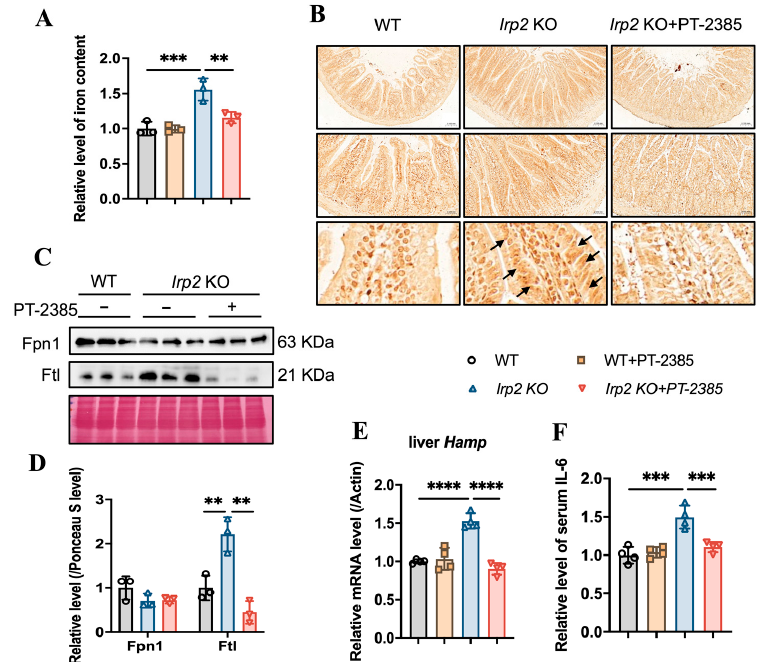
Figure 4. Abnormal iron accumulation is suppressed in the small intestine and hepcidin levels are downregulated in the liver of Irp2 KO mice by PT–2385 treatment. ( A ) Iron content in the small intestine determined by ferrozine assays. ( B ) Representative images of DAB-enhanced Prussian blue staining for iron in the small intestine. Arrows indicate iron-stained epithelial cells. ( C ) Protein levels of Fpn1 and Ftl revealed by Western blot analysis. Ponceau S stain was used as an internal control. ( D ) Quantification of ( C ) to show significance. ( E ) Relative mRNA levels of Hepcidin in the liver, detected by RT-PCR. ( F ) Relative serum IL-6 levels, detected by ELISA. n ≥ 3. Results are shown as mean ± SD. One-way ANOVA was used for significance. ** p < 0.01, *** p < 0.001, **** p <